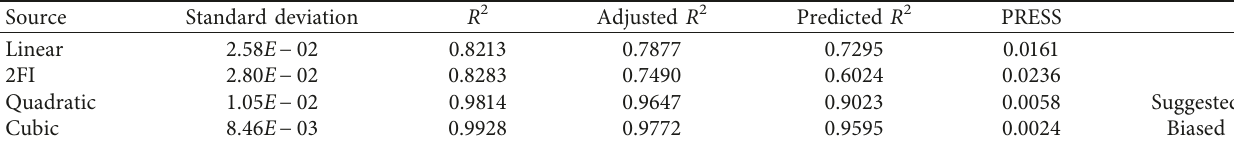
Table 4: Model summary